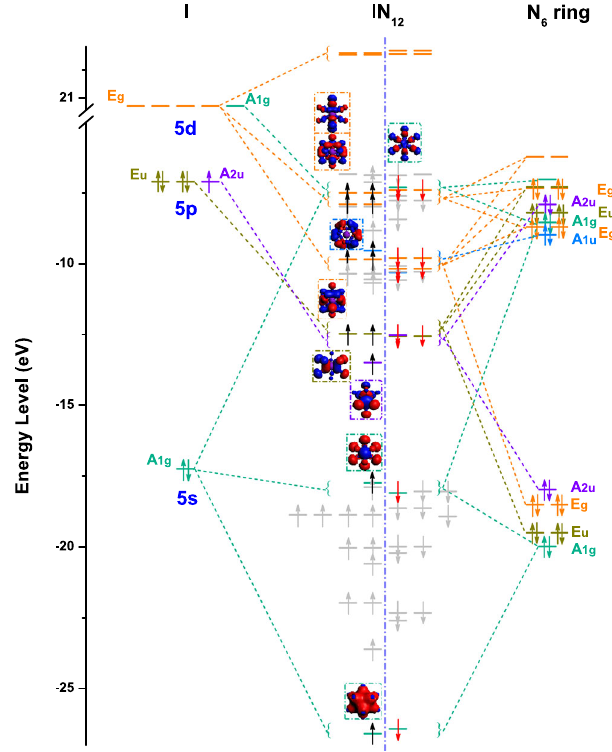
Fig. 4 Molecular orbital (MO) energy level diagram. The icosahedral cage-like IN 12 molecular fragment with D 3d point group symmetry. Besides gray annotated MOs of icosahedral cage-like IN 12 , others mainly consist of I and N 6 ring components.